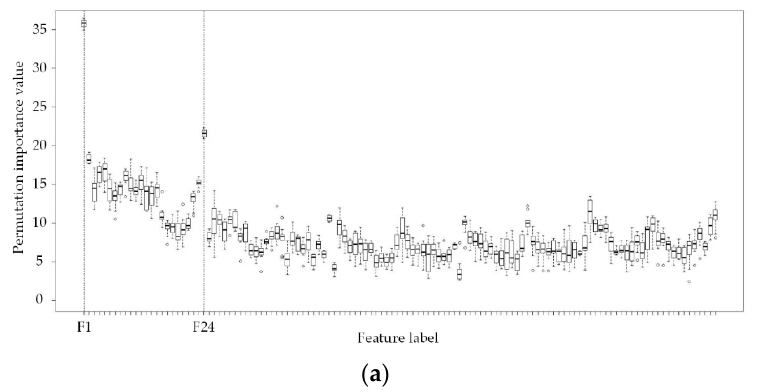
Table 3. The composition of original feature set used for day ‐ ahead